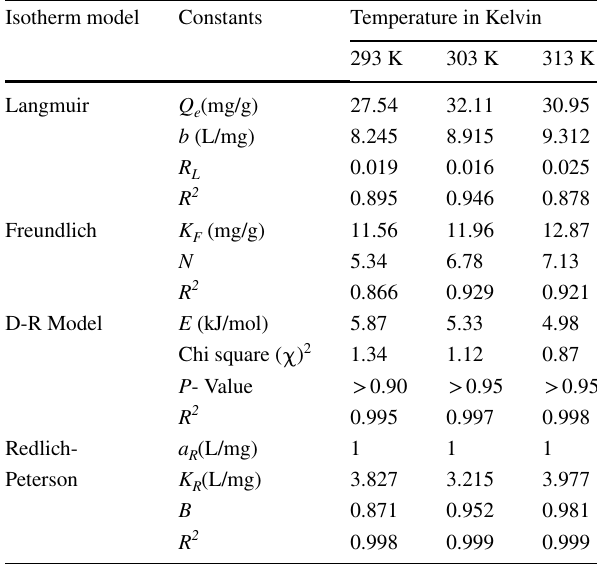
Table 1 Several isotherm parameters for MR adsorption onto